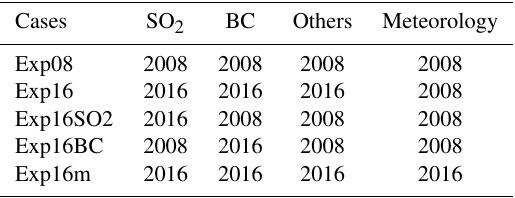
Table 1. Model experiments with anthropogenic emissions in China for the years 2008 and 2016. SO 2 : sulfur dioxide; BC: black carbon; Others: the anthropogenic emissions of reactive gases and aerosols other than BC and SO 2 . Cases SO 2 BC Others